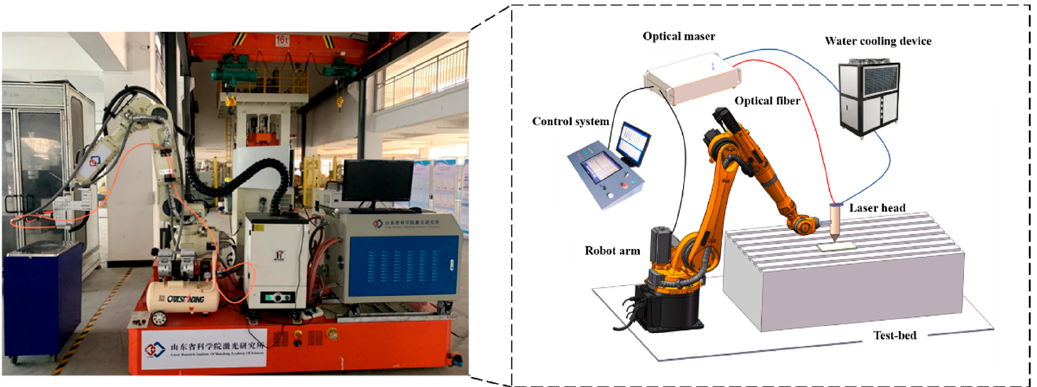
Figure 1. Schematic diagram of the laser cleaning equipment.